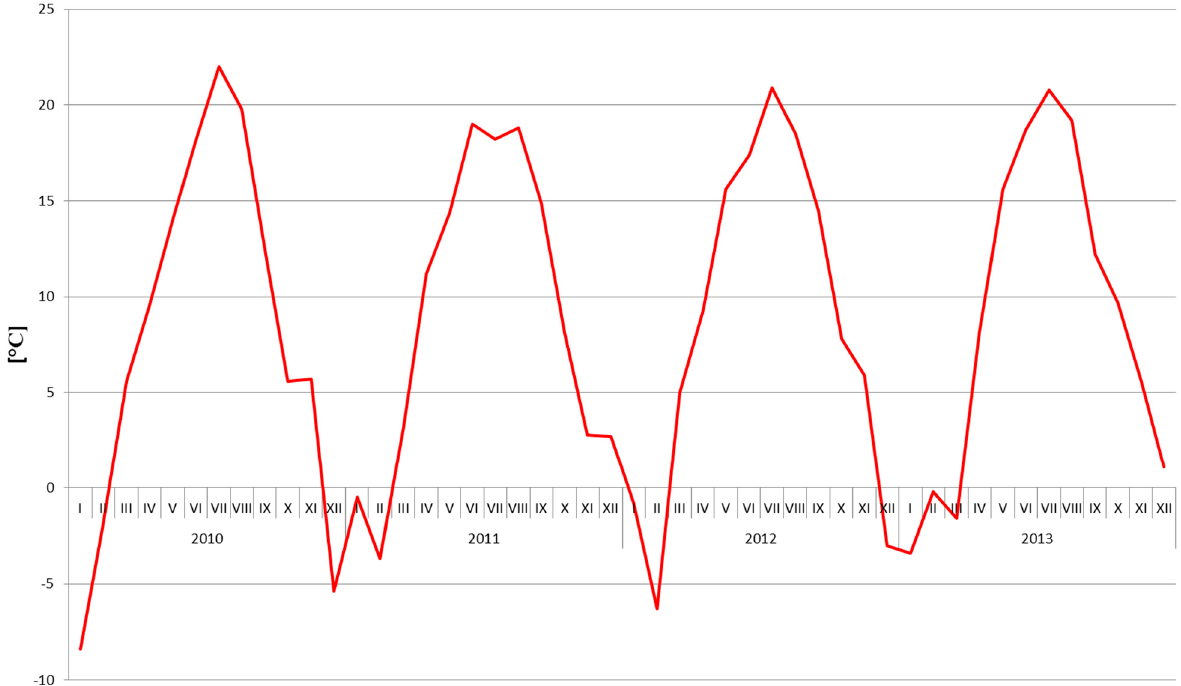
Figure 1. Temperature conditions on experiment area in years 2010–2013.